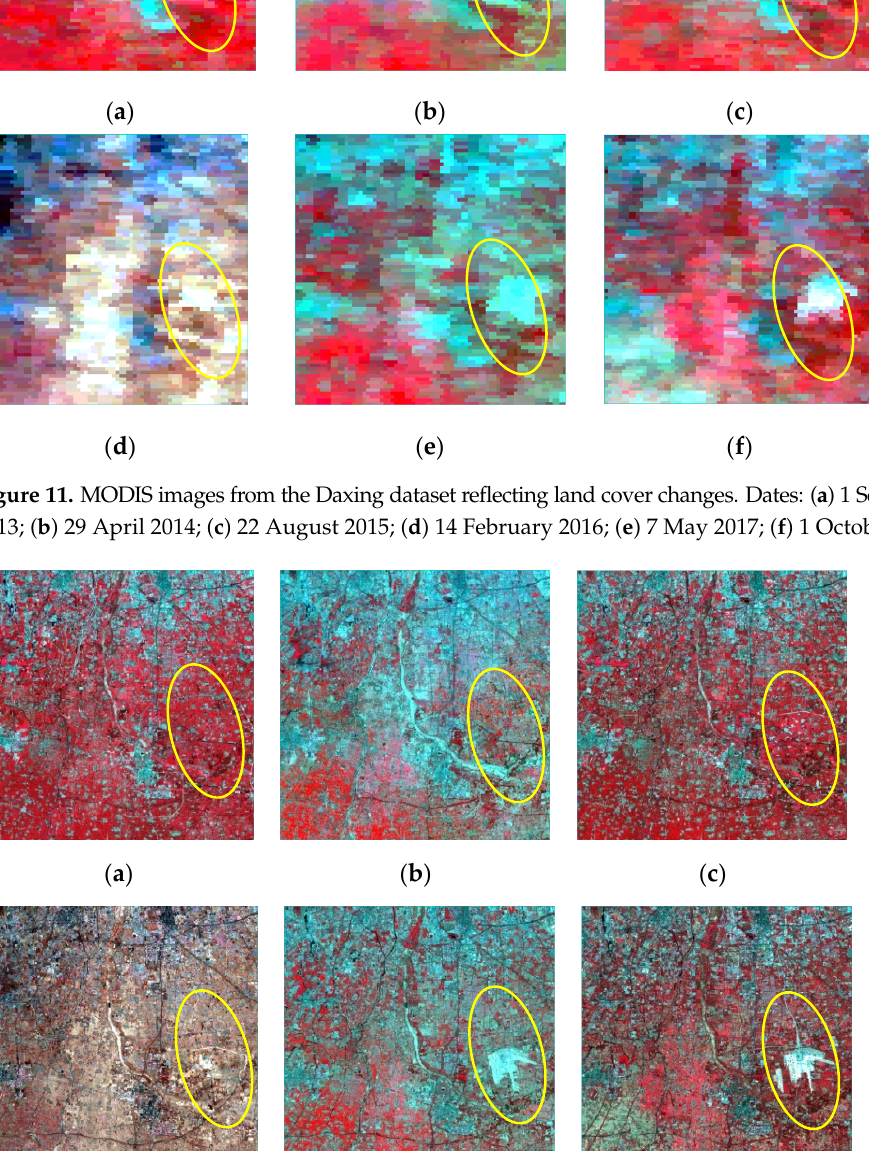
Figure 12. Landsat images from the Daxing dataset reflecting land cover changes. Dates: ( a ) 1 Sep-